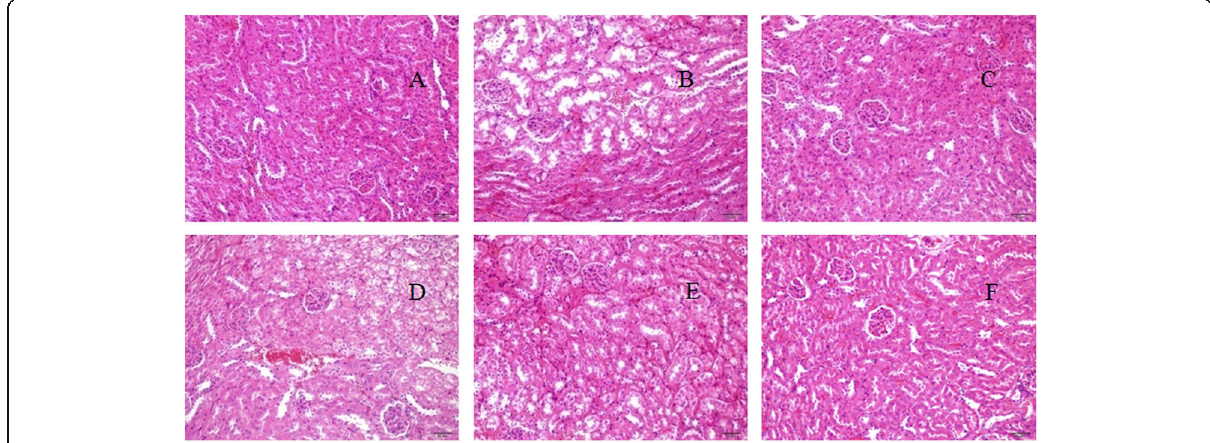
Fig. 3 Histopathological observation of kidney in aging mice. Magnification, × 200: a normal control group; ( b ) model control group; ( c ) positive control group; ( d ) RIP of low dose group; ( e ) RIP of medium dose group; ( f ) RIP of high dose